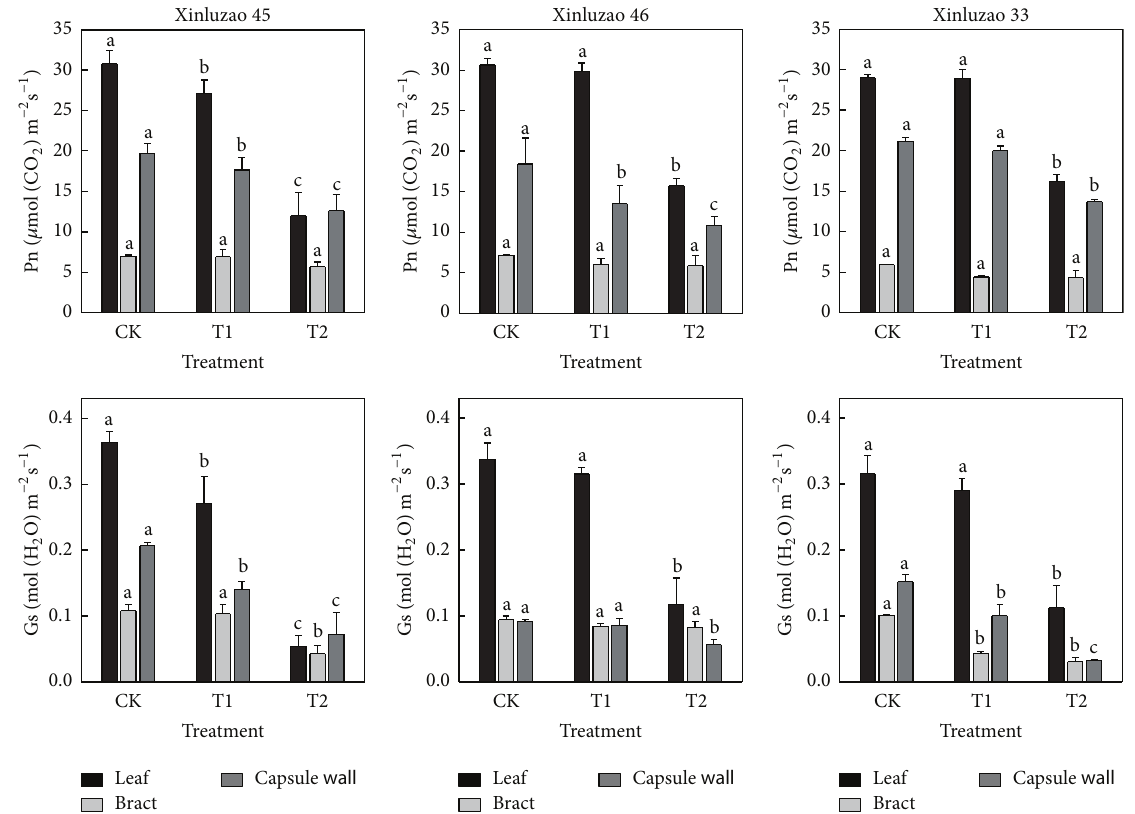
Figure 1: Gas-exchange parameters of leaves, bracts, and capsule walls in three cotton cultivars at the full boll stage in 2012. CK: conventional irrigation; T1: slight deficit irrigation; T2: moderate deficit irrigation. Different letters within a cultivar and within a plant organ are significantly different at the 0.05 probability level. Table 2: Photosynthetic rates of whole leaves, whole bracts, and whole capsule walls at the full flower and the full boll stages in 2013.